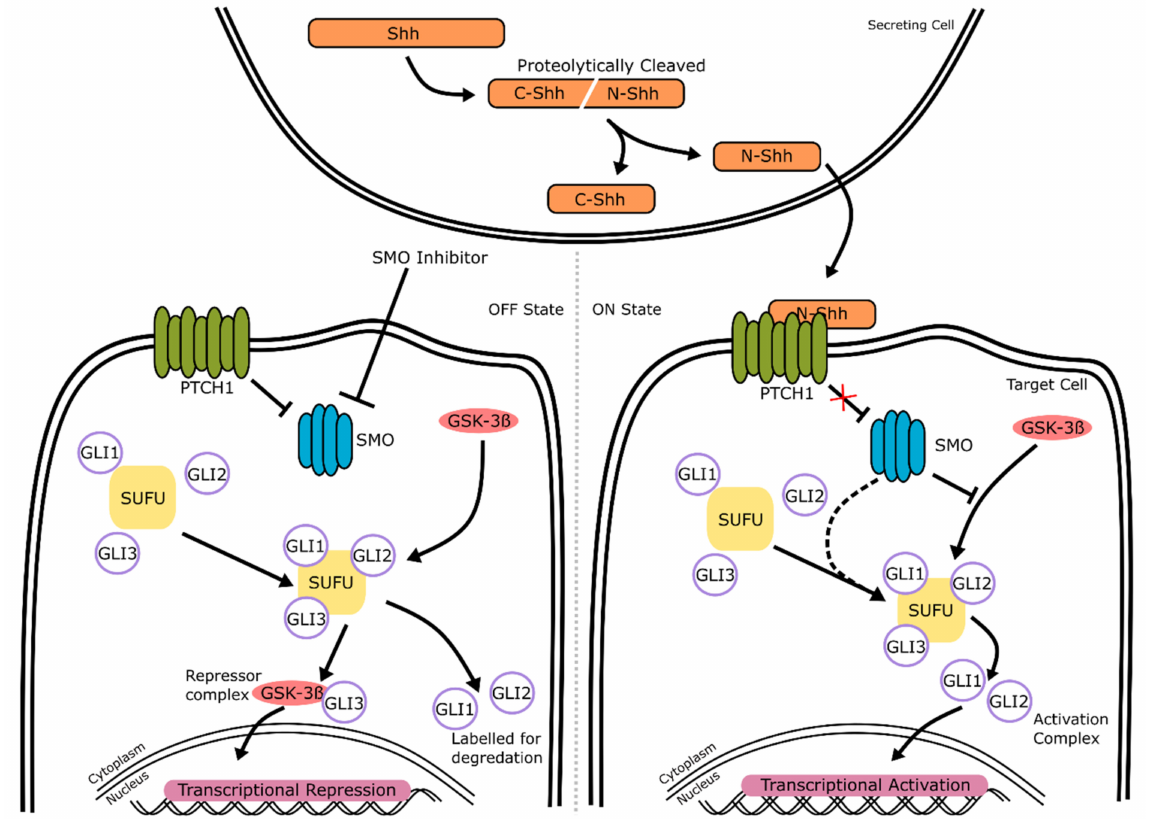
Figure 2. The hedgehog signaling pathway. ( Top —Stage 1): to initiate hedgehog signaling, the secreting cell cleaves the Shh protein into two domains: N-Shh and C-Shh. N-Shh is then secreted into the extracellular domain. ( Left —Stage 2): cells that have not yet been targeted by Shh exist in an “OFF State”. In this state, PTCH1 inhibits Smo, which allows SUFU to bind the Gli proteins, keeping them in an inactive state. Gli3 forms a repressor complex with GSK-3 β , whilst Gli1 and Gli2 are marked for degradation. The repressor complex translocates to the nucleus, where it represses gene transcription. ( Right —Stage 3): once the N-Shh has bound to the transmembrane protein PTCH1, cells transition into an “ON State”. In this state, PTCH1 no longer inhibits Smo, which in turn stops SUFU-mediated inactivation of the Gli proteins. This impedes the formation of the repressor complex and allows Gli1 and Gli2 to form an activation complex, which translocates to the nucleus and activates the transcription of target